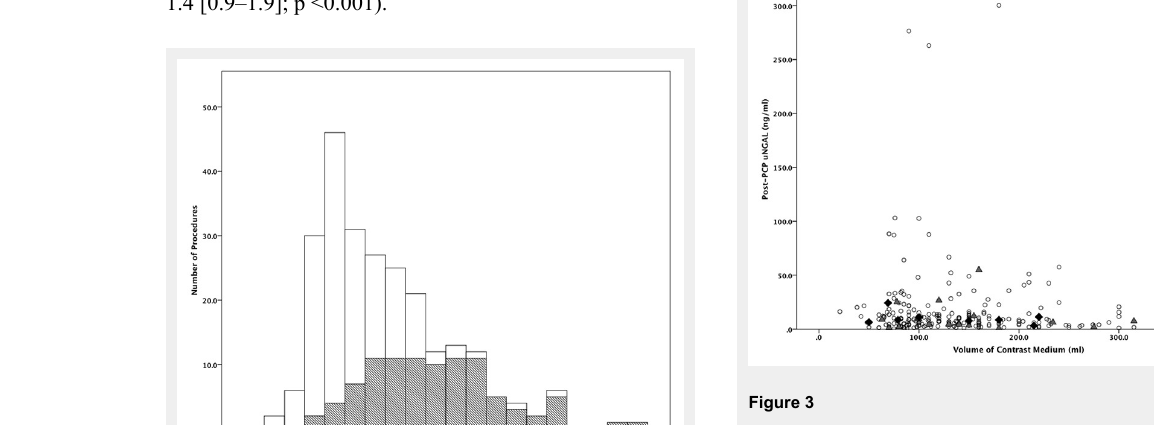
Relationship between the volume of contrast medium used and the post-PCP uNGAL levels in patients without CI-AKI (white disk), and with CI-AKI defined by the classical criteria (grey triangle) or by the AKIN criteria (black diamond) (normal uNGAL range ≤132 ng/ml). CI-AKI = contrast-induced acute kidney injury; PCP = percutaneous coronary procedure; uNGAL = urinary neutrophil gelatinase- associated